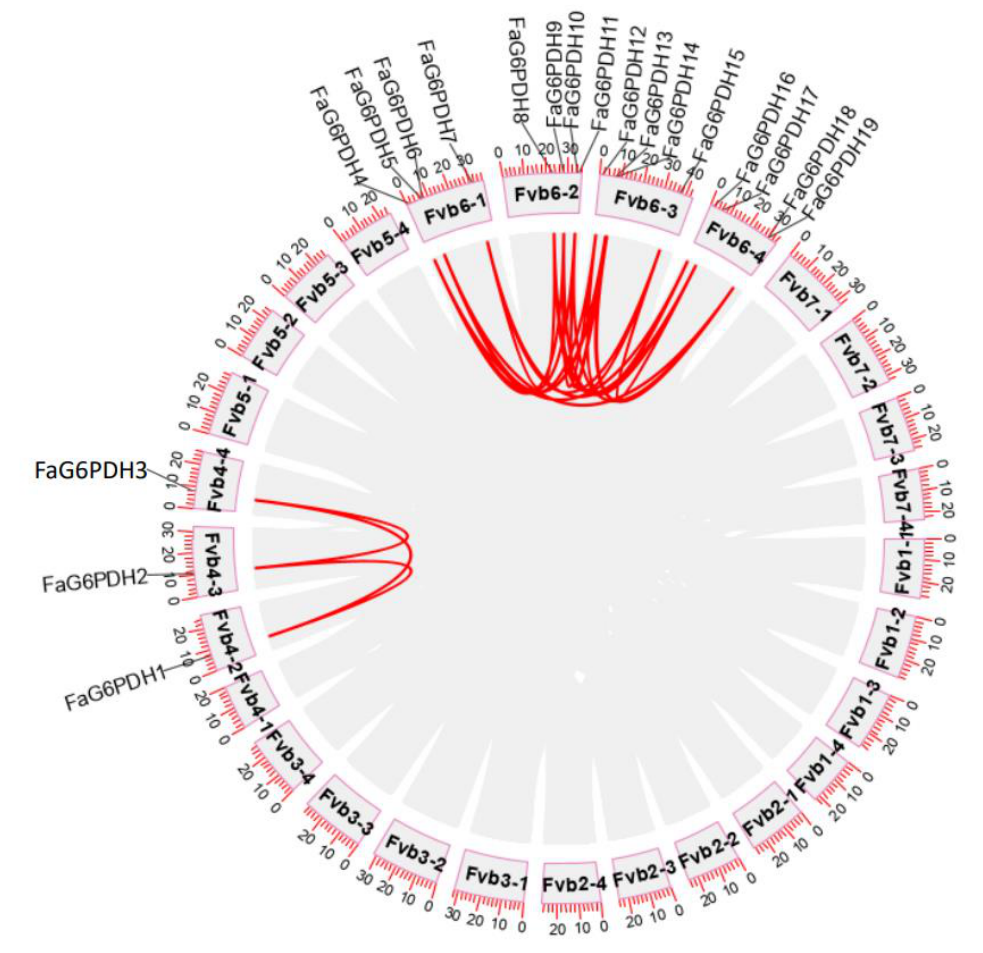
Figure 4. Synteny analysis of FaG6PDHs.